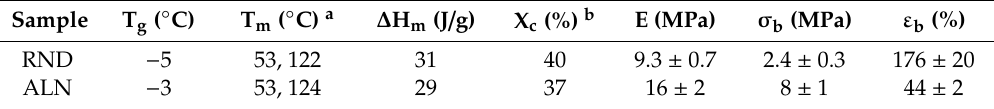
curves of RND (a, black) and ALN (b, blue) scaffolds. Table 1. Calorimetric and mechanical data of RND and ALN sca ff olds. Table 1. Calorimetric and mechanical data of RND and ALN scaffolds.